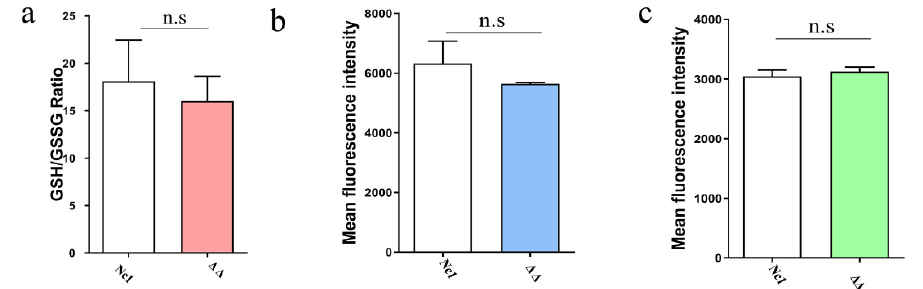
Figure 6. grx C5 and grx S14 double-gene deficiency did not affect the levels of GSH, ROS and OH. ( a ) ∆ grx S14 ∆ grx C5 and Nc1 parasites were collected and lysed by three cycles of freezing in liquid nitrogen and thawing at 37 °C. The supernatant of each sample was collected for GSH and GSSG measurement. The GSH/GSSG ratio was calculated, as represented by bar charts according to three independent experiments. ( b ) Reactive oxygen species (ROS) levels of parasites under oxidative stress were determined by FACS analysis using DCFH-DA, whereby the mean fluorescence intensity reflected the ROS level in parasites. ( c ) The hydroxyl radical (OH) content was detected by FACS analysis, with the mean fluorescence intensity reflecting the hydroxyl radical level. n.s: not signifi- cant means.